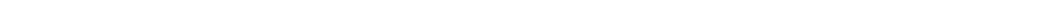
(see fi gure on previous page) Fig. 4 Gcm1 competes with β -catenin for binding to TCF4 and is associated with Wnt target genes expression. a ChIP-qPCR analysis of Gcm1, β -catenin and TCF4 enrichment in Wnt-responsive element (WREs) of Axin2 in control and folate-de fi cient mESCs. NEG negative control, TSS transcription start site. Right panel: the locations of the WRE and NEG in the promoter. b ChIP-qPCR analysis of Gcm1, β -catenin, and TCF4 enrichment in the WREs of Bcl9l in control and folate-de fi cient mESCs. Right panel: the locations of the WREs and NEG in the promoter. c ChIP-qPCR analysis of Gcm1, β -catenin, and TCF4 enrichment in the WREs of Isl1 in control and folate-de fi cient mESCs. Right panel: the locations of the WREs and NEG in the promoter. d Functional clustering of genes associated with Gcm1 ChIP-peaks in mESCs with folate de fi ciency (the top 10 categories are shown). The X -axis represents the log10 value of the binomial raw P value. e Pathway analysis of Gcm1 ChIP-peaks in mESCs with folate de fi ciency (the top 10 categories are shown). Gcm1 binding pathway enrichment was determined using PANTHER analysis. The X -axis represents the enrichment factor, the Y -axis represents the binomial raw P value, and the size of each circle represents the number of genes. f Representative examples of Ctla4 and Edn1 chromatin binding. A segment of chromosome 1 demonstrates the decreased binding of Clta4 to a TBE in folate- de fi cient compared to normal mESCs. A segment of chromosome 13 demonstrates the decreased binding of Edn1 to a TBE in folate-de fi cient group compared to normal mESCs. g ChIP-qPCR analysis of Clta4 and Edn1 in mESCs with folate de fi ciency. * P = 0.015 ( Clta4 ) and * P = 0.022 ( Edn1 ). h The mRNA expression of Clta4 (J) and Edn1 (K) in mESCs with folate de fi ciency. * P = 0.015 ( Clta4 ) and * P = 0.04 ( Edn1 ). i Correlation analysis between ChIP density and the mRNA expression of Clta4 and Edn1 . The correlation coef fi cients for Clta4 is 0.739 ( P = 0.003), and for Edn1 is 0.45 ( P = 0.002). j Correlation of the tag densities ( Y -axis) with the transcription levels of genes from − 3 kb to + 3 kb ( X -axis). All the genes were divided into fi ve groups based on their transcription levels from high (dark blue) to low (orange). The mean-normalized ChIP-seq densities with 1-bp resolution are plotted within a 6-kb region fl anking the TSS or the TTS (transcription termination site). Data a – c , g – i represent the mean ± SEM ( n = 3). The p value was calculated by Student ’ s t- test, ns was for no signi fi cance, * P < 0.05, ** P < 0.01, *** P <